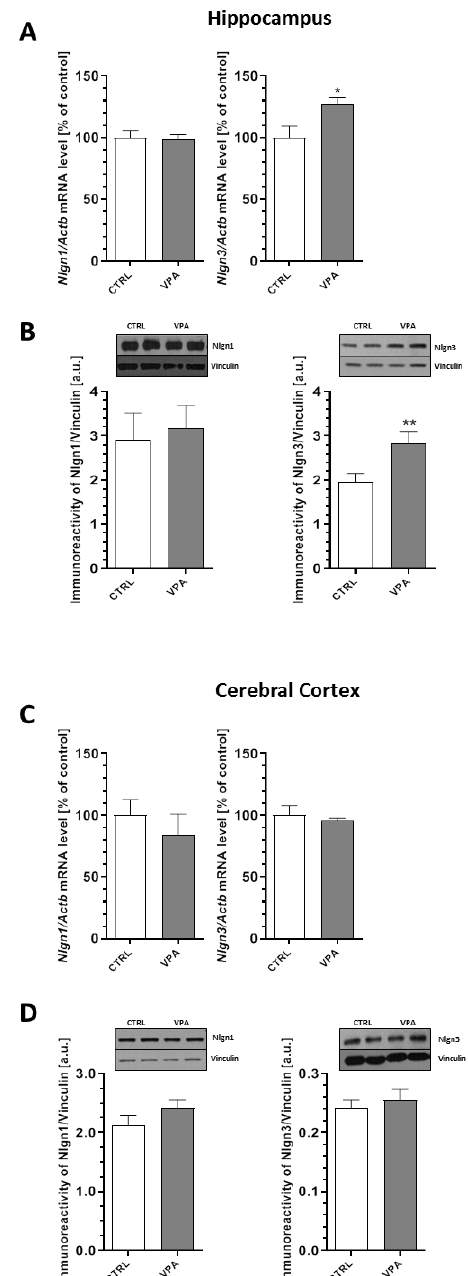
Figure 6. The e ff ect of prenatal exposure to VPA on the expression of the synaptic cell adhesion molecules: Nlgn1 and Nlgn3. The gene expression of Nlgn1 and Nlgn3 in the hippocampus ( A ) and cerebral cortex ( C ) of the control and VPA-exposed rats was measured with quantitative RT-PCR and calculated by the ∆∆ Ct method with Actb ( β -actin) as a reference gene. The data represent the mean values ± SEM from n = (5–6) independent experiments in both the hippocampus and cerebral cortex. The immunoreactivity of Nlgn1 and Nlgn3 in the control and VPA-exposed brains was monitored using a Western blot analysis. Densitometric analysis and representative pictures for Nlgn1 and Nlgn3 in the hippocampus ( B ) and cerebral cortex ( D ) are shown. Results were normalized to vinculin levels. Data represent the mean values ± SEM from n = (11–14) independent experiments in both the hippocampus and cerebral cortex. * p < 0.5, ** p < 0.01 vs.